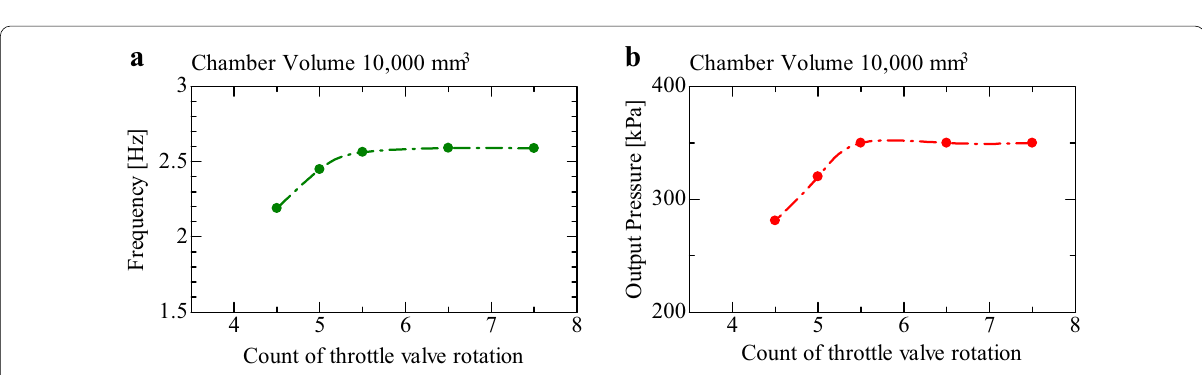
Fig. 10 Frequencies and output pressures affected by the amount of the input flow. a Relationship between the rotation of the throttle valve and the frequency. b Relationship between the rotation of the throttle valve and the output